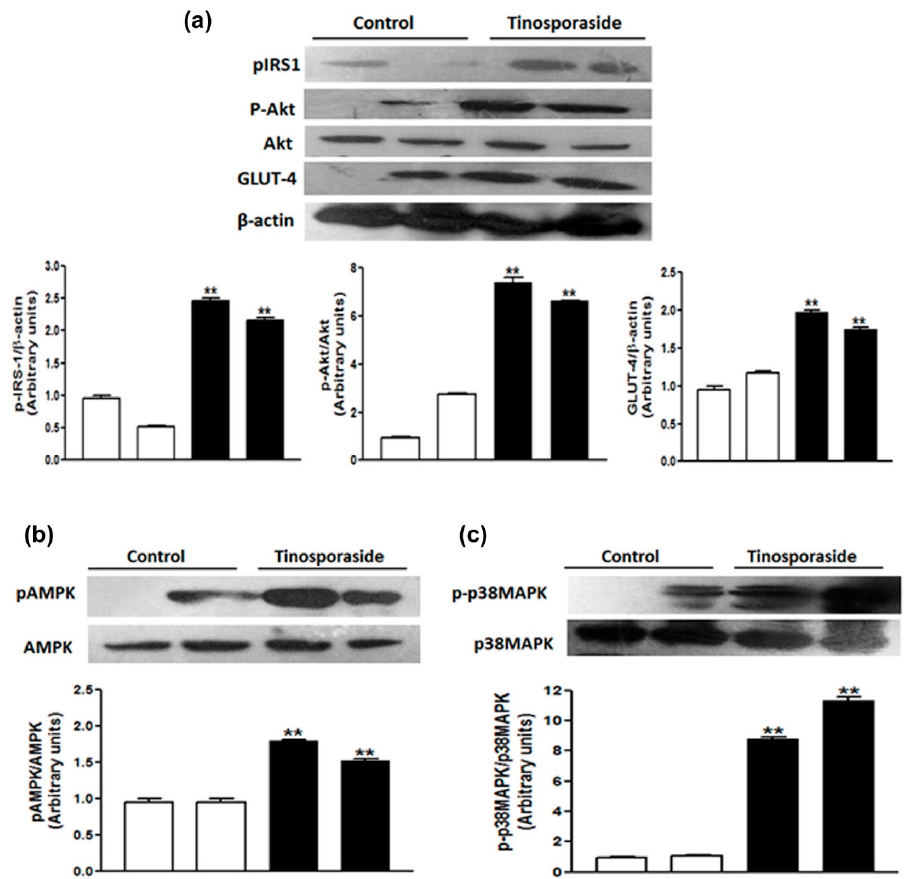
Figure 8. Tinosporaside-stimulated glucose uptake is mediated by activation of PI3K/AKT- and AMPK-dependent pathways. Western blot analysis of phospho-IRS-1, phospho-Akt, Akt and GLUT4 ( a ), phospho-AMPK ( b ) and p38 MAPK ( c ) in skeletal muscle of db/db mice treated with vehicle (white bars) or tinosporaside (Black bars) are presented. Results are expressed as the mean ± SE. ** p < 0.01, relative to control condition.